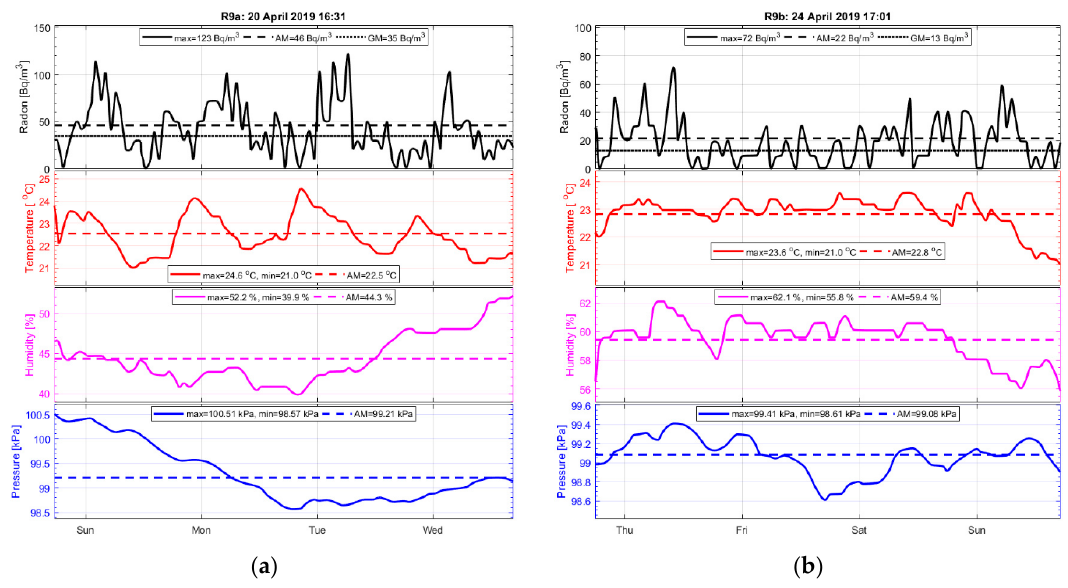
Figure 3. Radon measurements in family house (R9). ( a ) Basement-garage, ( b ) dining room. For each floor, 4 sublots are shown within time and days of measurements: radon concentrations, indoor temperature, humidity and air pressure with arithmetic mean and geometric mean values shown in legend. Day tick marks 00:00 time.